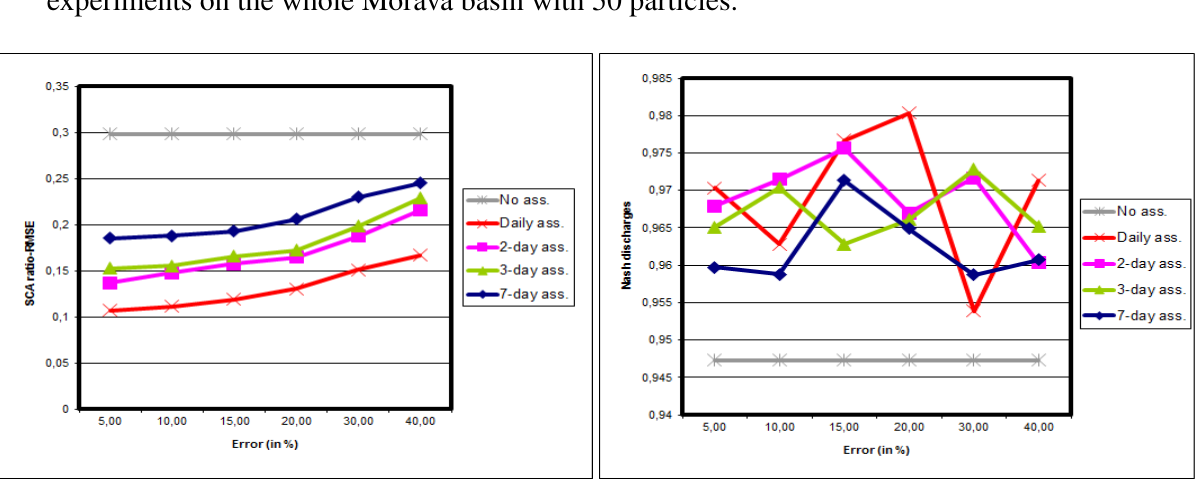
Figure 7. SCA ratio-RMSE ( left ) and Nash ( right ) for the synthetic SCA particle filter experiments on the whole Morava basin with 50 particles.